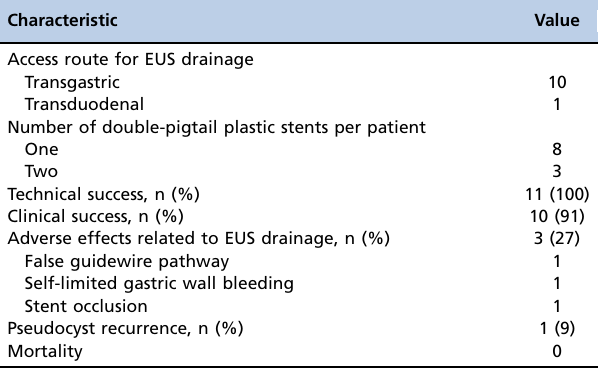
Table 2 - Outcomes of EUS-guided drainage of pancreatic pseudocysts using double-pigtail plastic stents (N=11). Characteristic Value Access route for EUS drainage